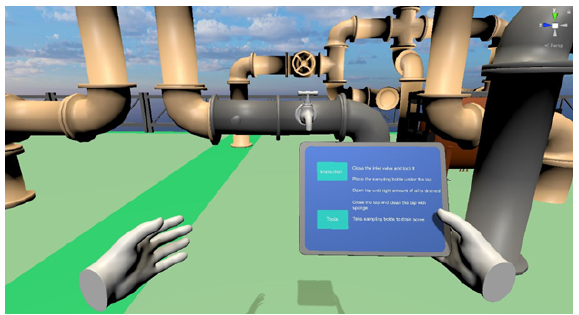
Figure 2. Module 1 Oil